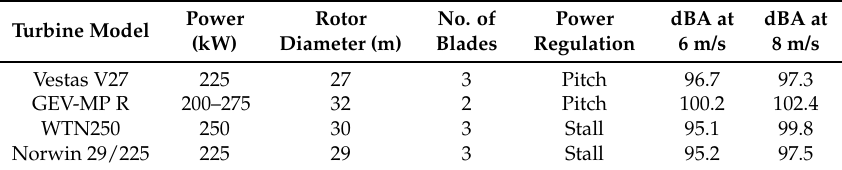
Table 3. Noise emission and specifications of horizontal axis wind turbines (HAWTs) in comparison. Wind speeds for noise emissions are stated for 10 m above ground